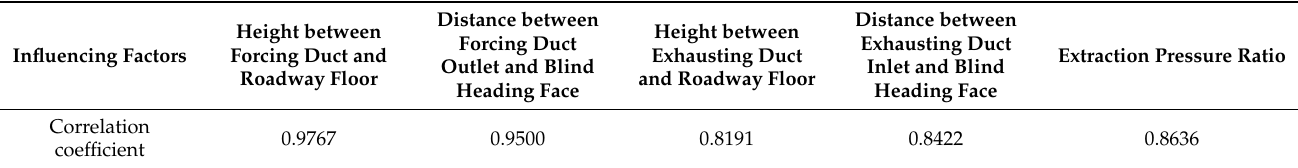
Table 4. Calculation results of the correlational